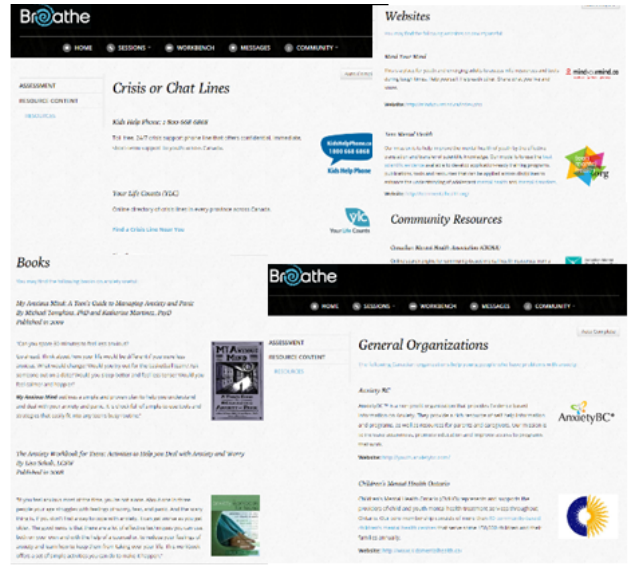
Figure 5. A collage of screenshots from the resource-based webpages.